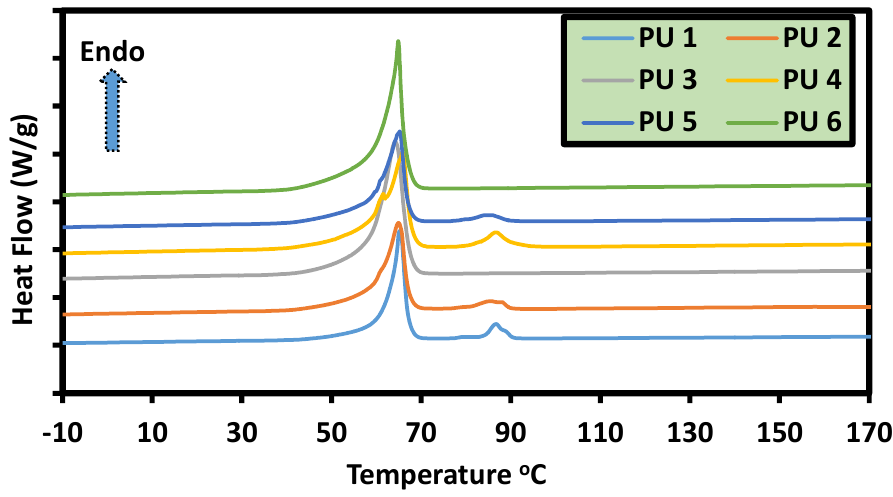
Figure 6. First heating DSC curves of PUs 1–6 presented in the temperature range from − 10 °C to 170 °C. Table 5. Melting temperature (T m ), melting enthalpy ( ∆ H m ), and crystallinity values obtained from DSC measurements for PCL and PPDL segments in PUs 1–6 by analysis of the first heating cycle.